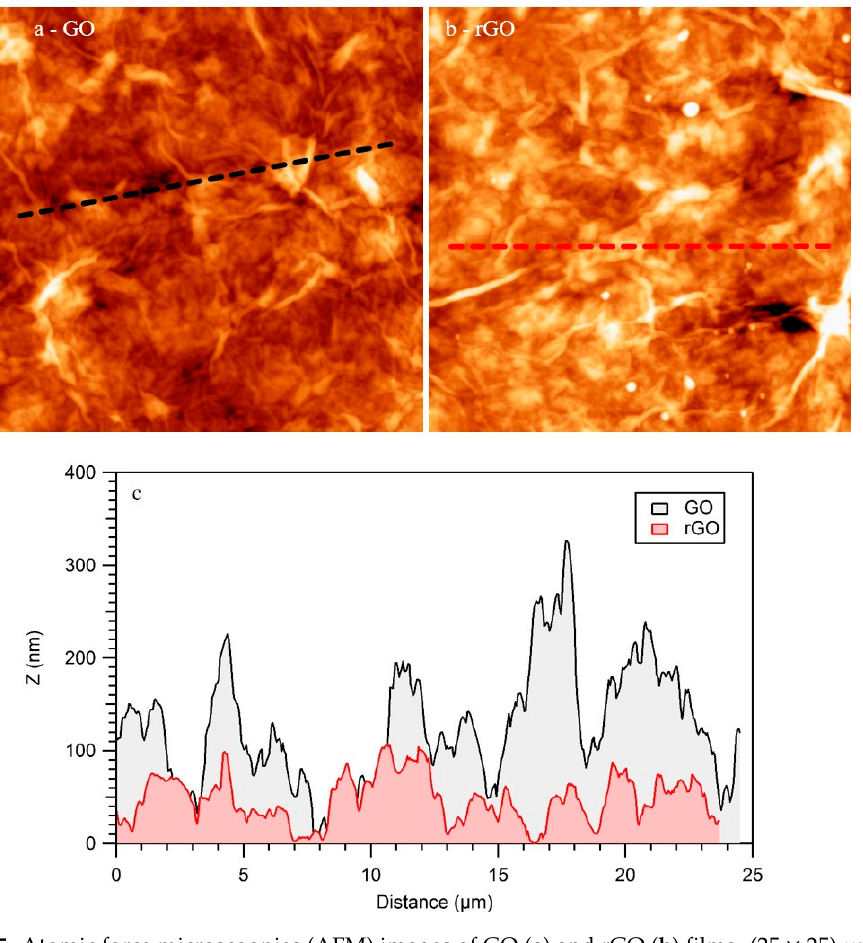
Figure 5. Atomic force microscoopies (AFM) images of GO ( a ) and rGO ( b ) films. (25 × 25) μ m 2 . ( c ) Height profiles indicated in (a-black) and (b-red).